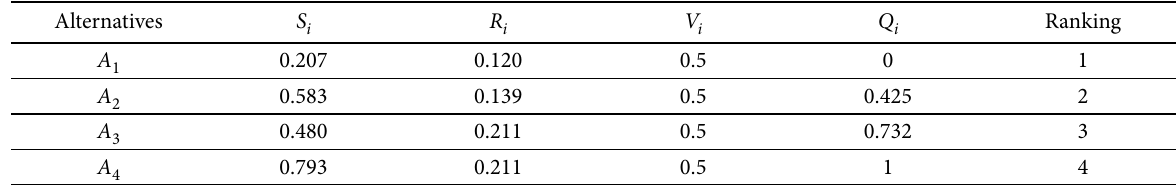
Table 9. Ultimate results and ranking of